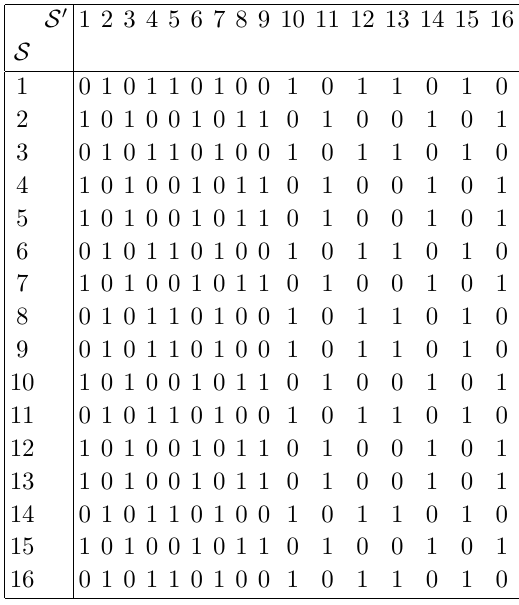
Table 25 . Gadget values for P